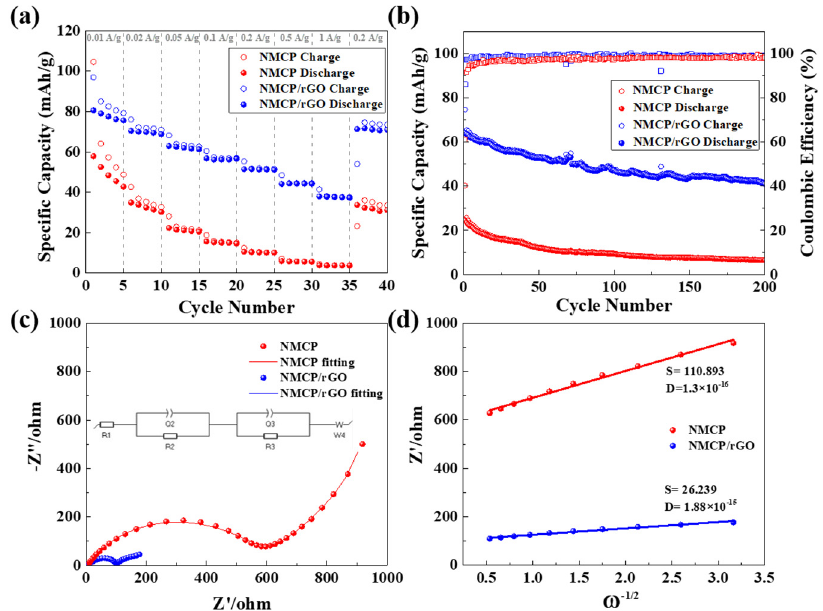
Figure 8. NMCP and NMCP/rGO ( a ) C-rate tests at 0.01 A/g to 1 A/g, ( b ) cycling performances at 0.1 A/g, ( c ) Nyquist plots along with the fitting curves and equivalent circuit, and ( d ) linear relationships between Z’ and the reciprocal square root of angular rate ( ω − 1/2 ) in the low frequency region.